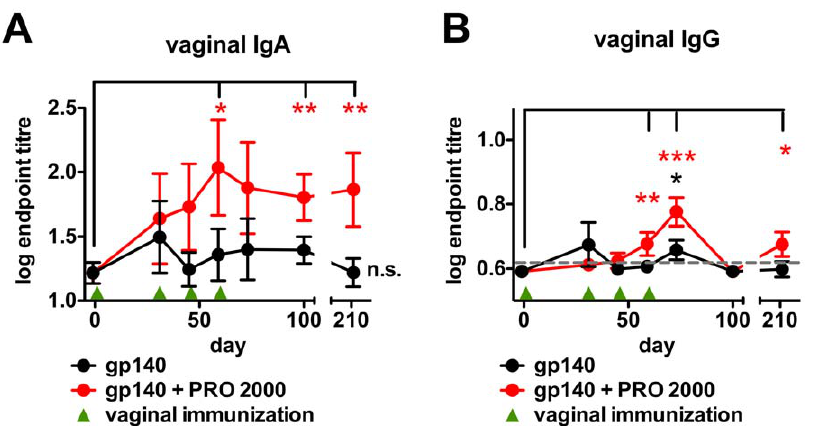
Figure 1. PRO 2000 co-application induces increased mucosal antibody responses in mice. BALB/c mice (n=7) were immunized four times vaginally with 12.5 m g gp140 + / 2 1% PRO 2000; Time courses of the vaginal lavage IgA ( A ) and IgG ( B ) endpoint titres. gp140 + PRO indicates combined gp140 and PRO 2000. Titre data were log-transformed and are shown as mean 6 SEM. The grey dashed line indicates the ELISA detection limit. * p , 0.05; ** p , 0.01. (Figure 4C, p = 0.0181, unpaired t -test) and significantly increased IgG1/IgG2a titre ratios (Figure 4D, p = 0.0379, Mann Whitney test) for animals receiving gp140 + PRO 2000 in FCA.